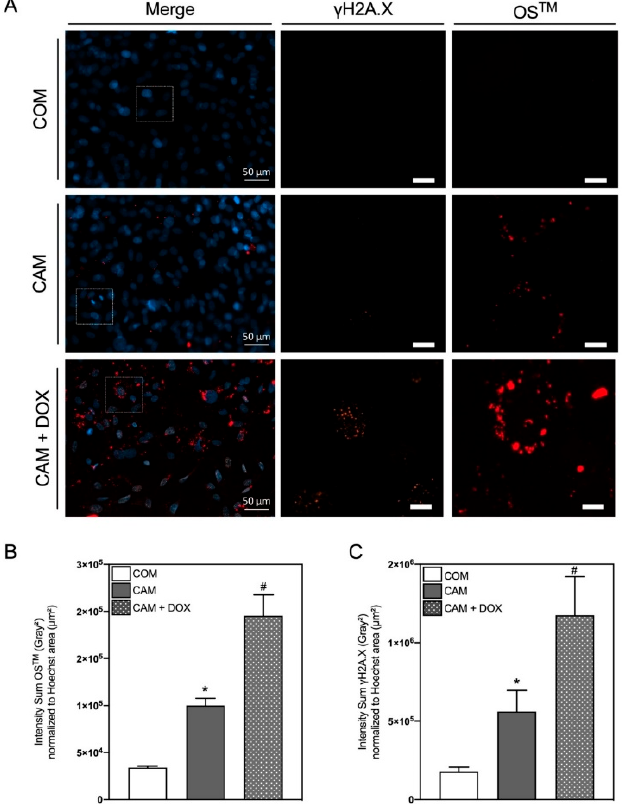
Figure 4. Co-staining of hydroxyapatite and gamma-histone H2A.X in vitro . ( A ) Representative im- ages of rat vascular smooth muscle cells (VSMC) stained for gamma-histone H2A.X ( γ H2A.X, orange channel), cell cores (Hoechst33342, blue channel) and hydroxyapatite (HAP) (OsteoSense™680EX (OS TM ), red channel) after stimulation in control medium (COM) or calcification medium (CAM) w/wo Doxorubicin (DOX) (500 nmol/L) for 7 d. The squares indicate areas of magnifications shown on the right side. ( B ) Quantification of OS TM fluorescence signals. ( C ) Quantification of γ H2A.X fluorescence signals. If not stated otherwise, the scale bar indicates a 10 µm section, n ≥ 3, mean ± SEM, * p < 0.05 in comparison to COM, # p < 0.05 in comparison to CAM.